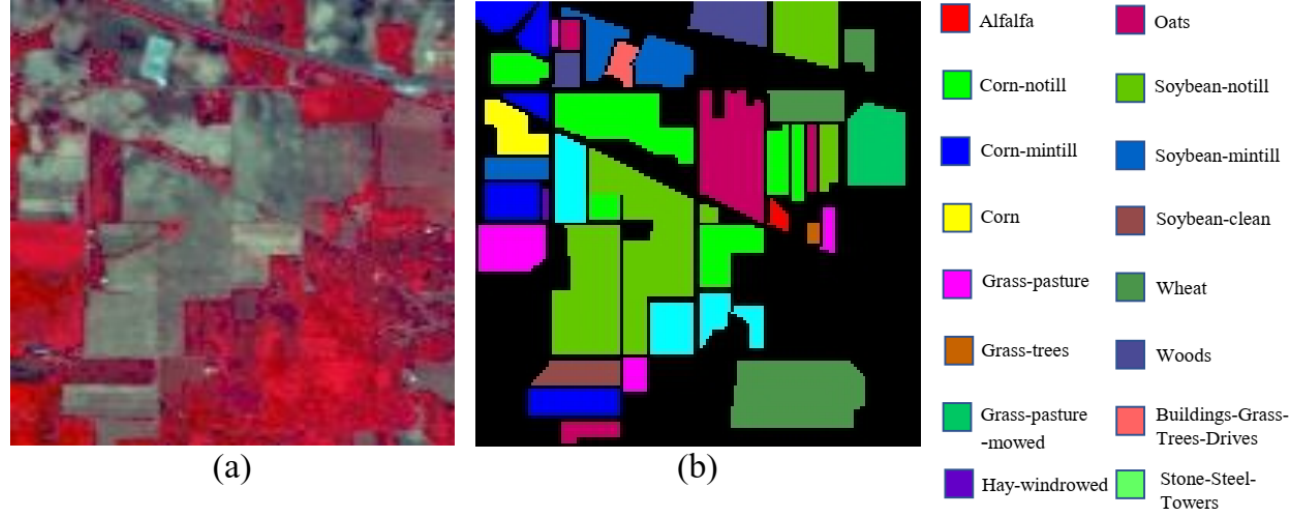
Figure 4. Indian Pines dataset. ( a ) False-color image; ( b ) Ground Truth. Table 2. Training and Test Samples for the IP Dataset.